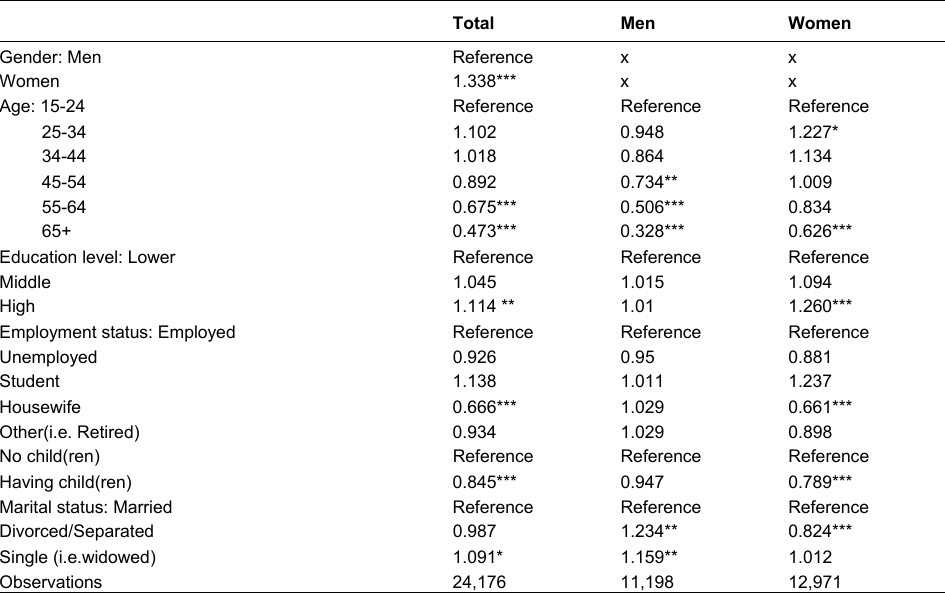
Table 3 : Results of logistic regression in Odds Ratios. Dependent variable: Agreement to nurturing father Total Men